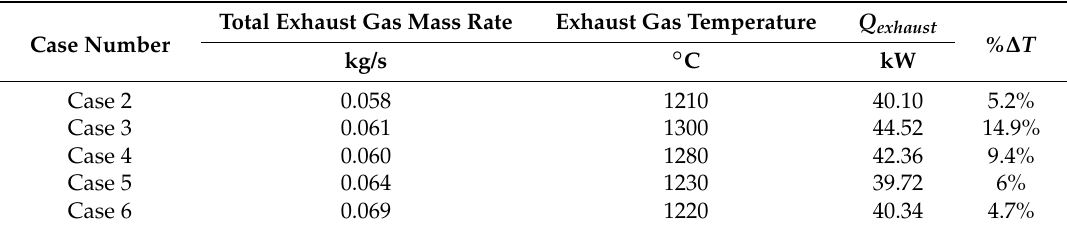
Table 7. Exhaust losses for cases 2, 3, 4, 5 and 6.